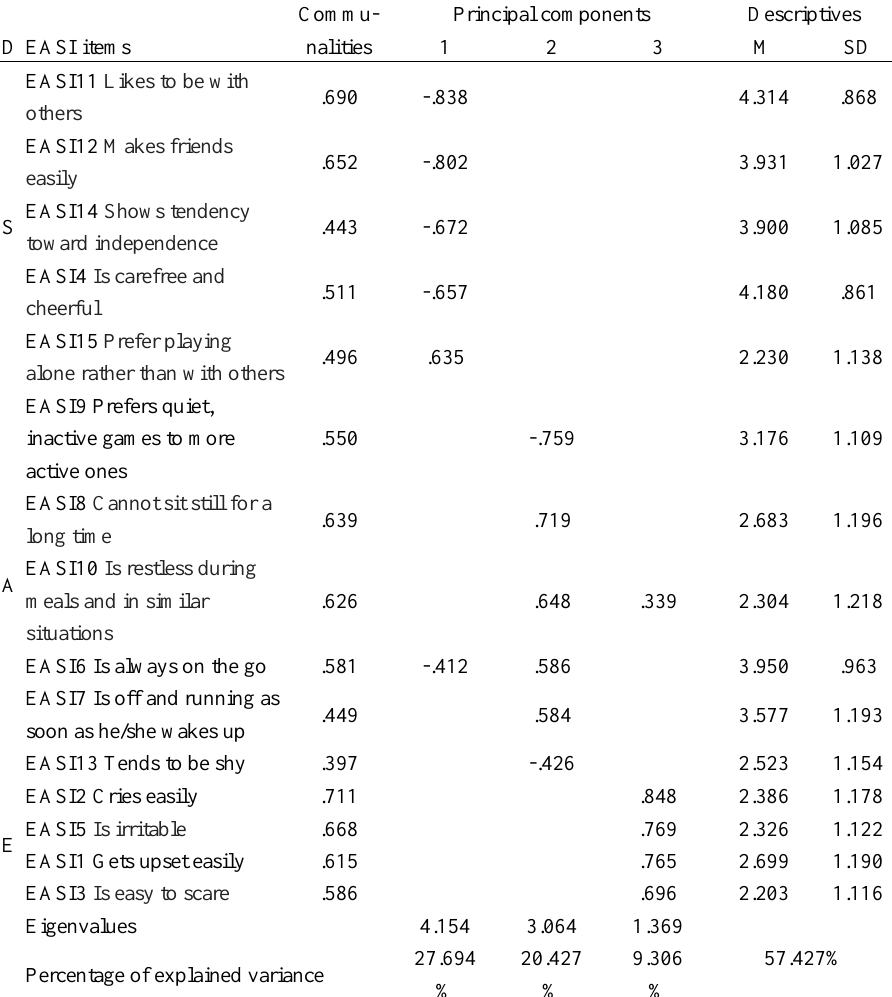
Final pattern matrix of principal components: Sociability=1, Activity=2, Emotionality=3, with Oblimin rotation, communalities and descriptives for